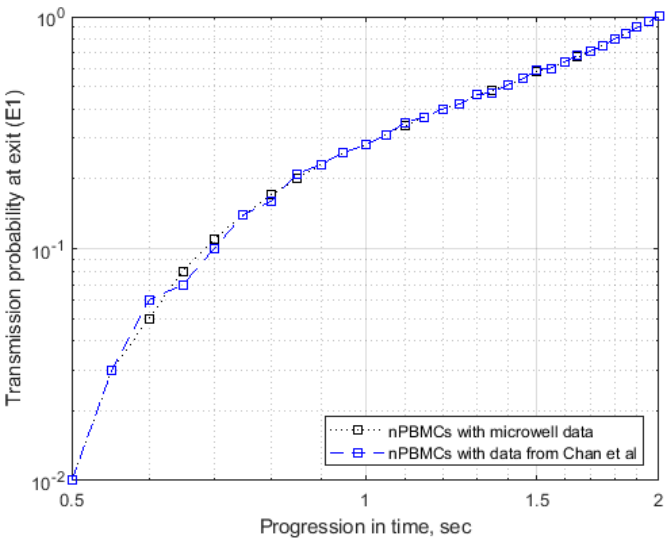
Figure 10. Validation of the electrophysiological properties of healthy PBMCs obtained from the DEP microwell platform using crossover frequency measurement and the literature reported values based on electro-rotation experiments [44]. Both the samples were derived from non-pregnant young ( < 50 years of women (< 50 years of age).